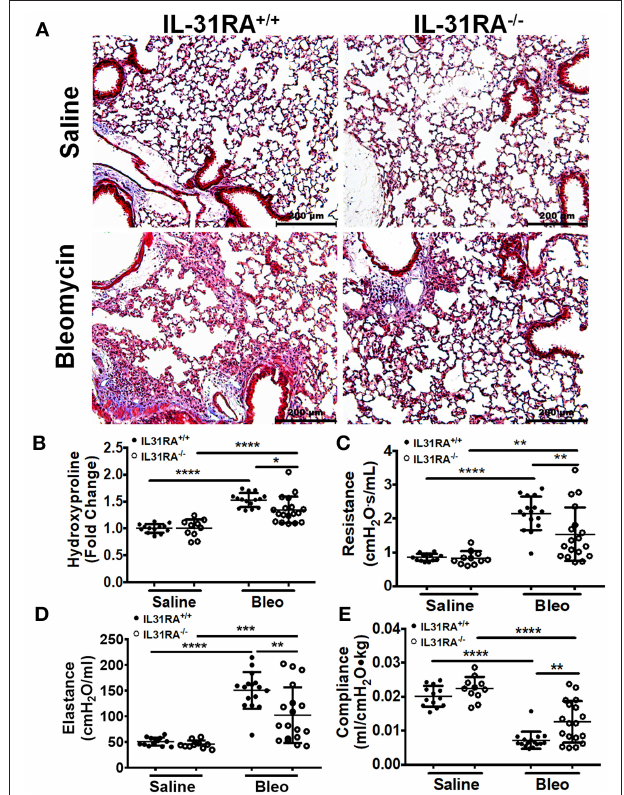
FIGURE 1 | The loss of IL-31RA signaling attenuates collagen deposition and lung function decline during bleomycin-induced pulmonary fibrosis. Wildtype (IL-31RA + / + ) and IL-31RA knockout (IL31RA − / − ) mice were treated intradermally with bleomycin or saline for four weeks to induce pulmonary fibrosis. (A) Lung sections of saline or bleomycin-treated mice were stained with Masson Trichrome. Scale bar 200 µ m. (B) Total lung hydroxyproline was compared between IL-31RA − / − and IL31RA + / + mice treated with bleomycin or saline. (C–E) Lung function measurements including resistance, elastance and compliance were measured in all four groups using FlexiVent. Data are presented as means ± SEM. The above data is cumulative of two independent experiments ( n = 12-19/group). Statistical analysis